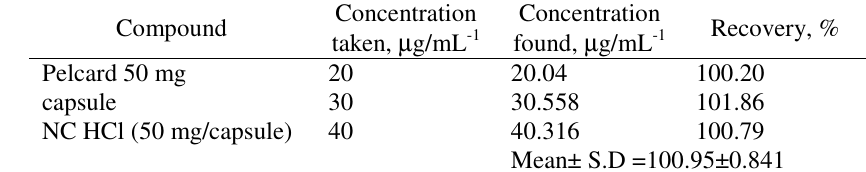
Table 6. Application of the proposed HPLC method to the determination of nicardipine in commercial